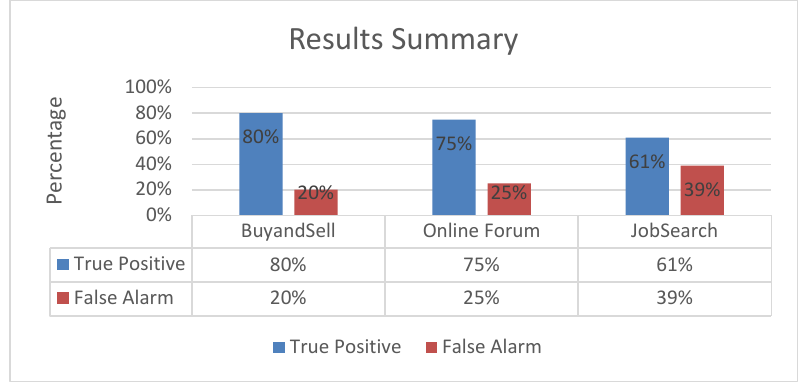
Fig. 10. Results summery for the experiments